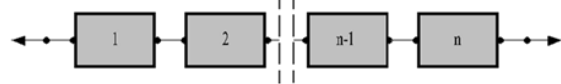
Figure 1: The n-members serial structures